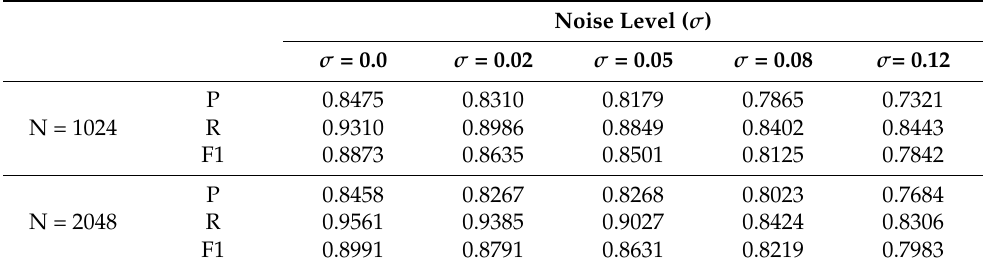
Table 2. The behavior of EDC-Net with different perturbed levels of noise on ABC